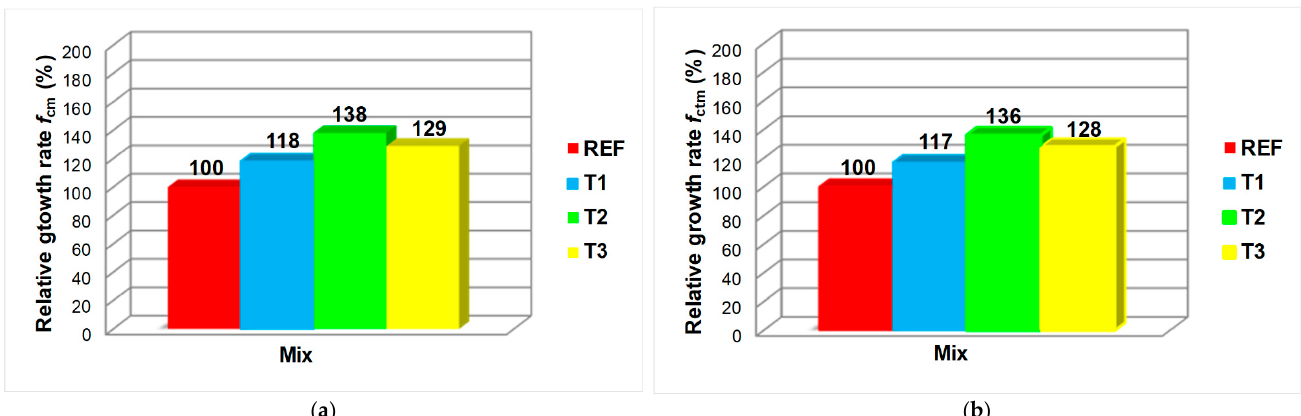
lyzed concretes.